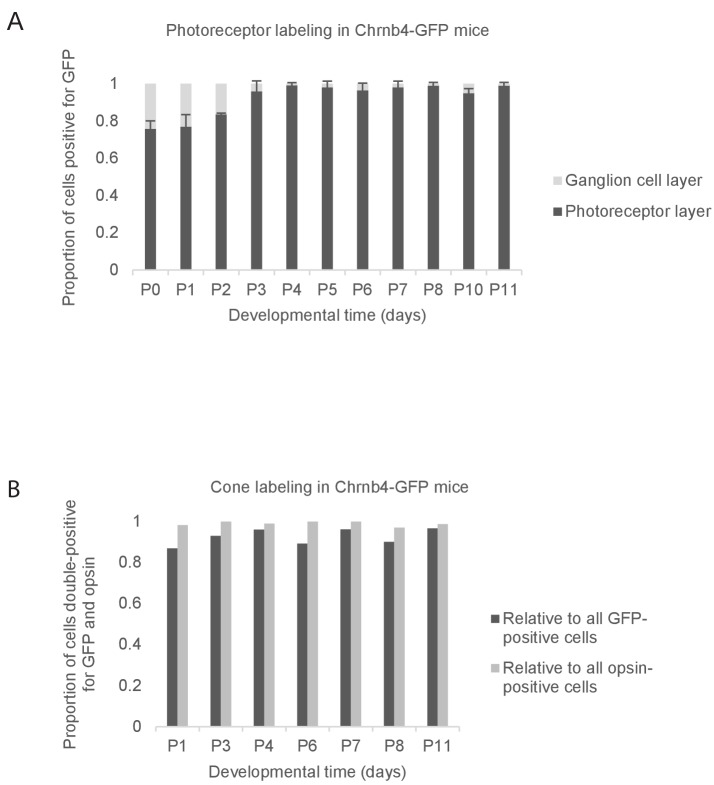
The identity of GFP-labeled cells in the retina of Chrnb4-GFP mice.(A) The distribution of GFP-positive cells across the different layers of the retina at different developmental days. The proportion of GFP-positive cells in the ganglion cell layer and in the photoreceptor cell layer relative to the total number of GFP-positive cells is shown. The quantification was performed on confocal microscopy images taken from retinal vibratome sections (n = 3 mice per day). Error bars show means ± s.d. (B) The proportion of cells in the photoreceptor layer that are positive for both GFP and cone opsin, relative to the total number of GFP-positive cells (dark grey) and relative to the total number of cone opsin-positive cells (light grey) is shown at different postnatal days. The quantifications were based on confocal microscopy images of retinal whole mounts stained against GFP and a mix of s- and m-/l-opsin (n = 1 mouse per day). Before P5, opsin signal was weak and confined to the cell bodies and inner segments. This opsin signal likely reflects S-opsin, because S-opsin is expressed from P0 onwards, while M/L-opsin only starts being expressed at P6.